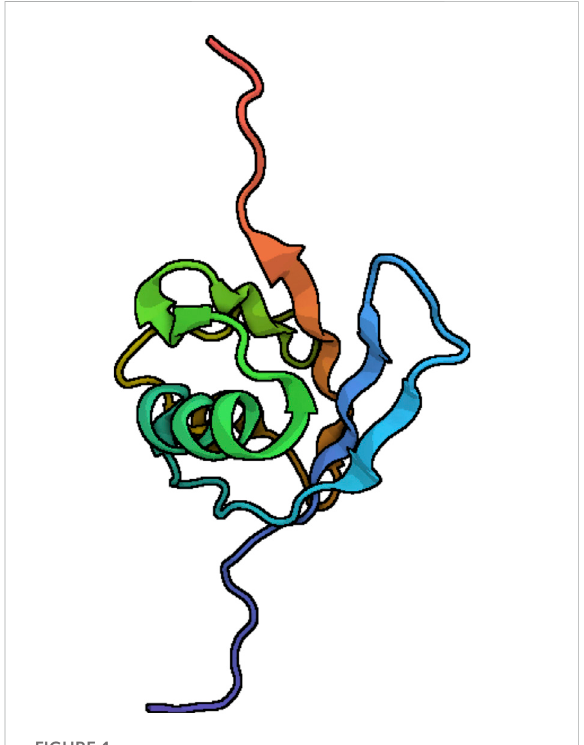
Ribbon diagrams of the FAT10 model structure. N-and C-terminal domains of FAT10 show the typical b-grasp fold. The central α -helix (turquoise) is made with β -sheets (Aichem et al., 2018). The diagrams were generated with the